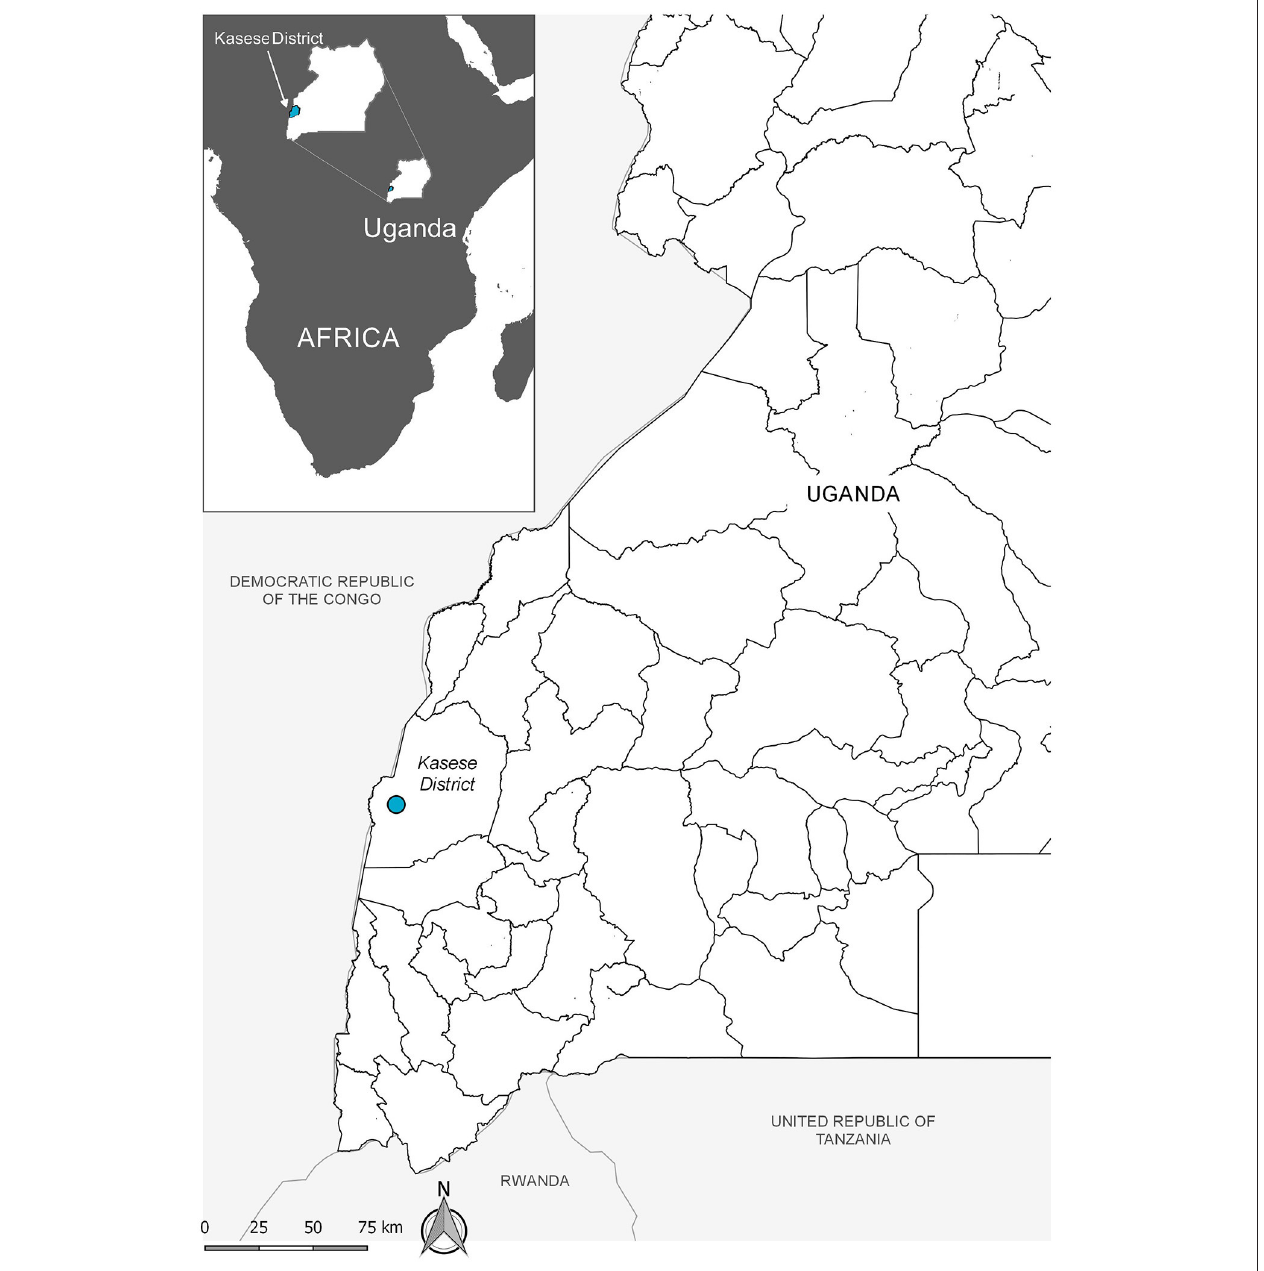
FIGURE 1 | The study village, marked as a dot on the map, is located in the western part of the “cattle corridor” stretching through Uganda in a north-westerly